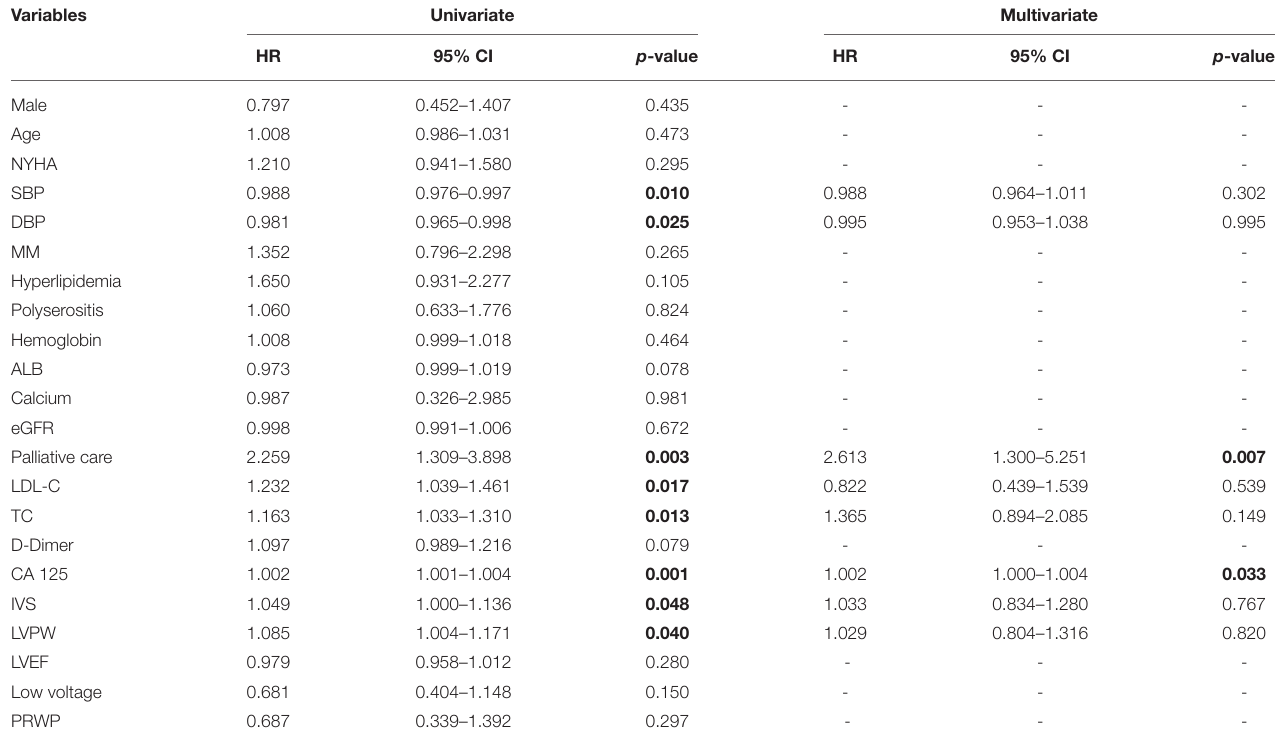
TABLE 2 | Univariate and multivariate Cox hazard analyses of predictors for all-cause mortality. Variables